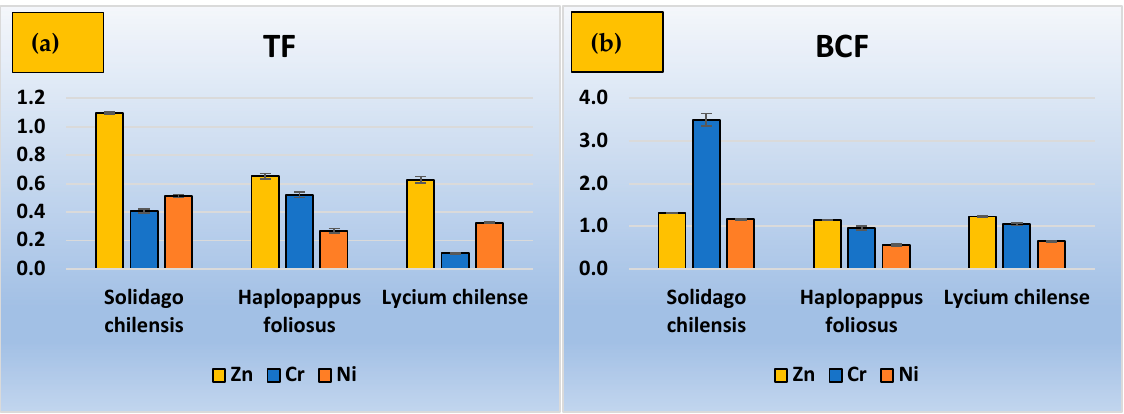
Figure 3. ( a ) Translocation factor, ( b ) bioconcentration factor.